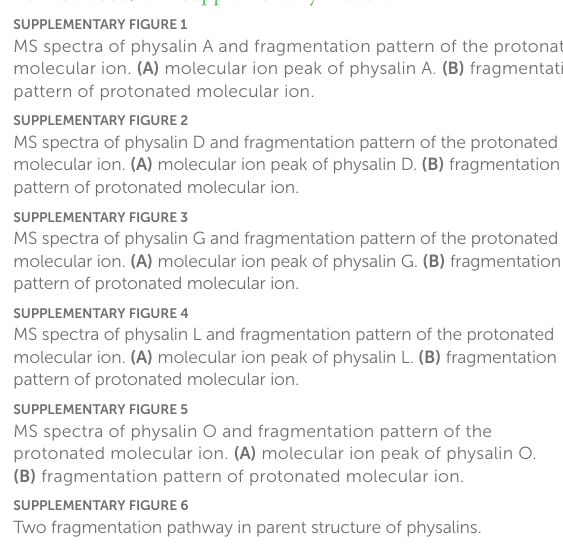
SUPPLEMENTARY FIGURE 1 MS spectra of physalin A and fragmentation pattern of the protonated